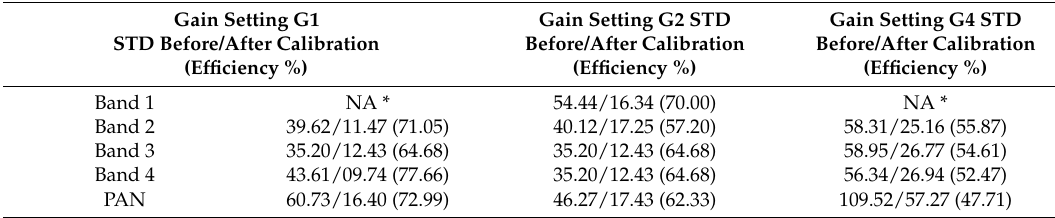
Table 6. The spatial variation of RSI spectral bands before and after normalizing calibration [31]. Gain Setting G1 STD Before/After Calibration (Efficiency %)